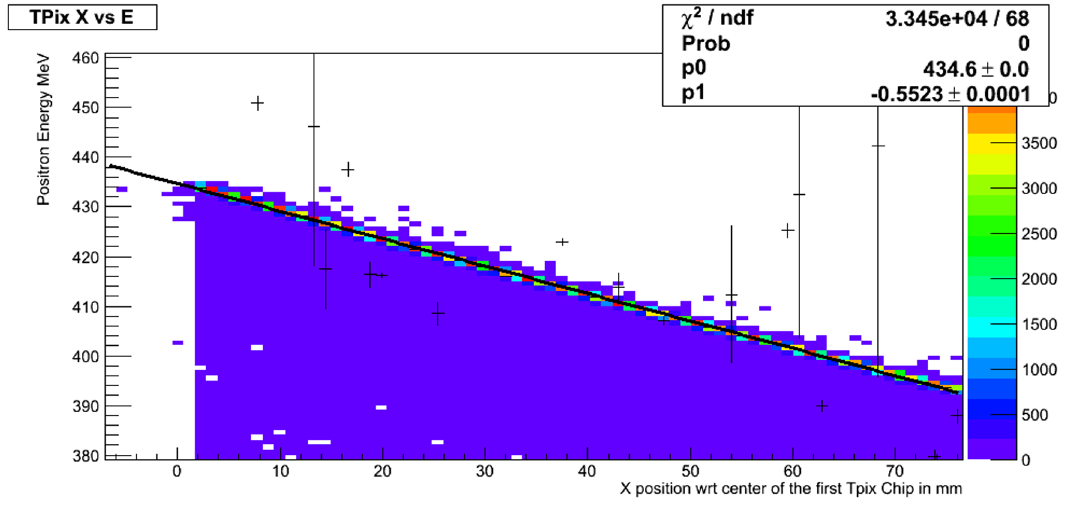
Figure 11 . Calibration of the positron beam impact point on the TimePix detector with the MC